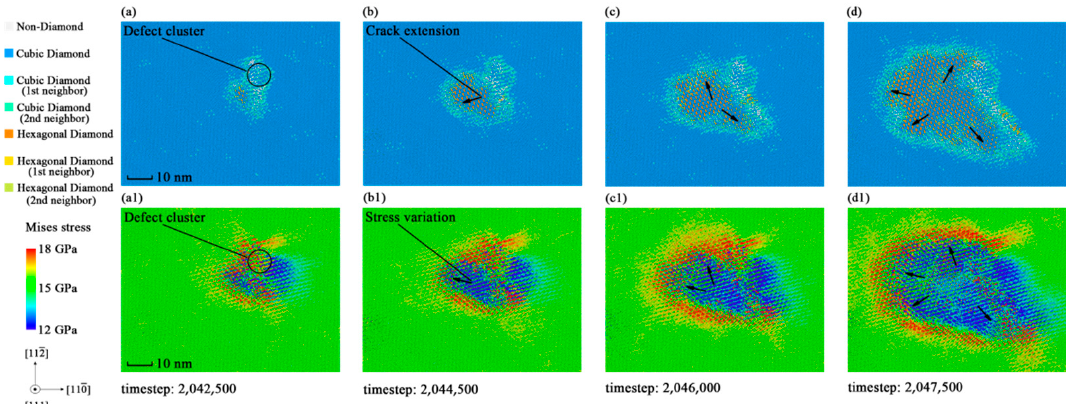
Figure 8. Crack variation and Mises stress variation of crystal plane in specimen 3 during the process of fracture: ( a ) Crack snapshot at timestep 2,042,500; ( b ) crack snapshot at timestep 2,044,500; ( c ) crack snapshot at timestep 2,046,000; ( d ) crack snapshot at timestep 2,047,500; ( a1 ) Mises stress snapshot at timestep 2,042,500; ( b1 ) Mises stress snapshot at timestep 2,044,500; ( c1 ) Mises stress snapshot at timestep 2,046,000; ( d1 ) Mises stress snapshot at timestep 2,047,500.